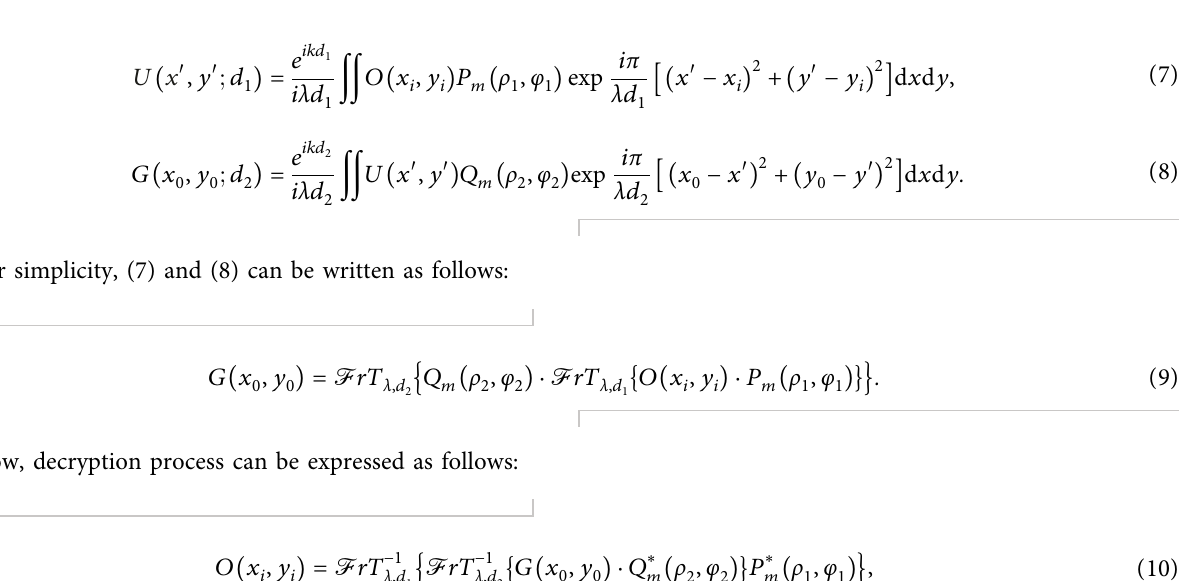
Figure 1: (a) Schematic setup of the DRPE in Fresnel domain illustrating the principle of the encryption system: O ( x object; RPM 1 and RPM 2, are random phase masks; G ( x distances between the planes. (b) 3D complex object used in the simulation: O is the distance between the two 2; d 0